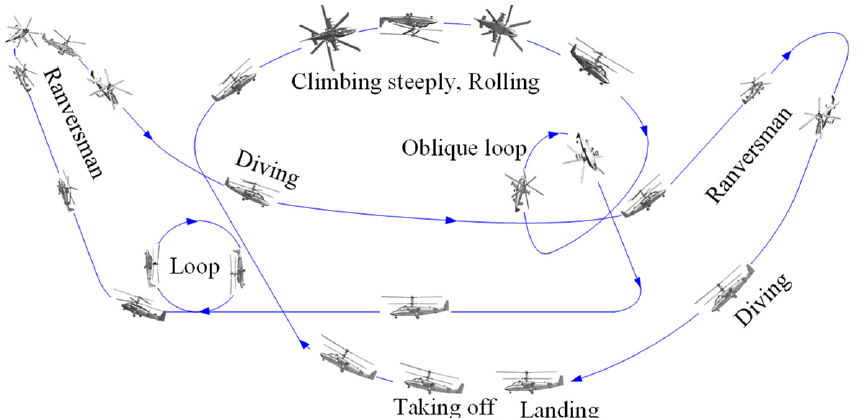
Figure 1. Schematic diagram of maneuvering flight.